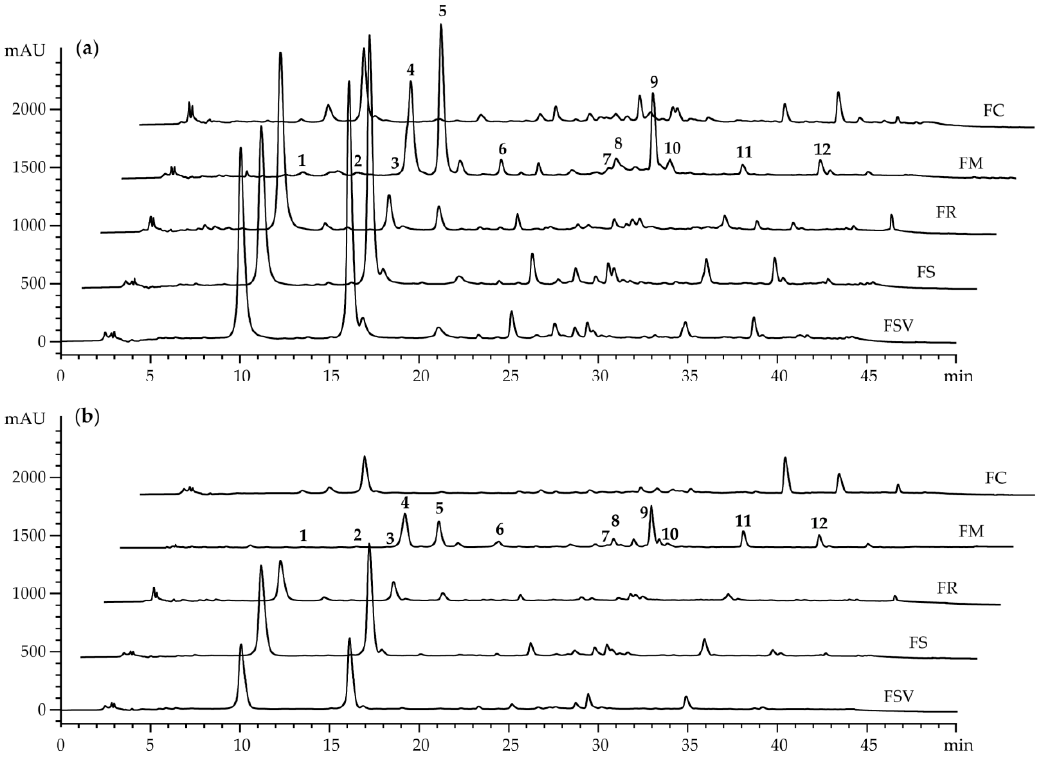
Figure 5. LC chromatograms of the extracts from the stem bark of five Fraxinus plants collected at summer ( a ) and autumn ( b ) seasons. FC, Fraxinus chiisanensis ; FM, F. mandshurica ; FR, F. rhynchophylla ; FS, F. sieboldiana ; FSV, F. sieboldiana var. angustata .